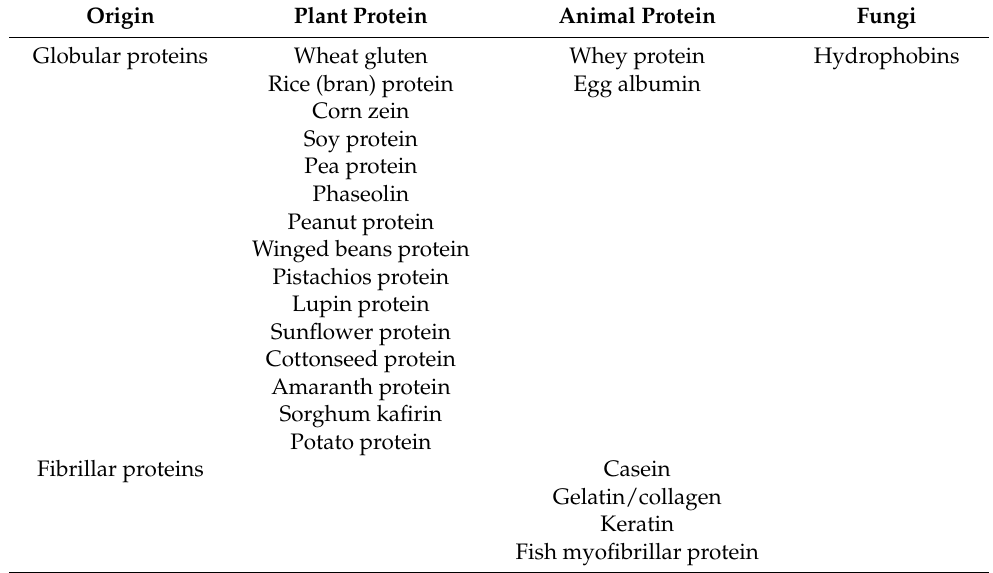
Table 1. Overview of proteins with film-forming properties tested for food packages, stand-alone films or edible